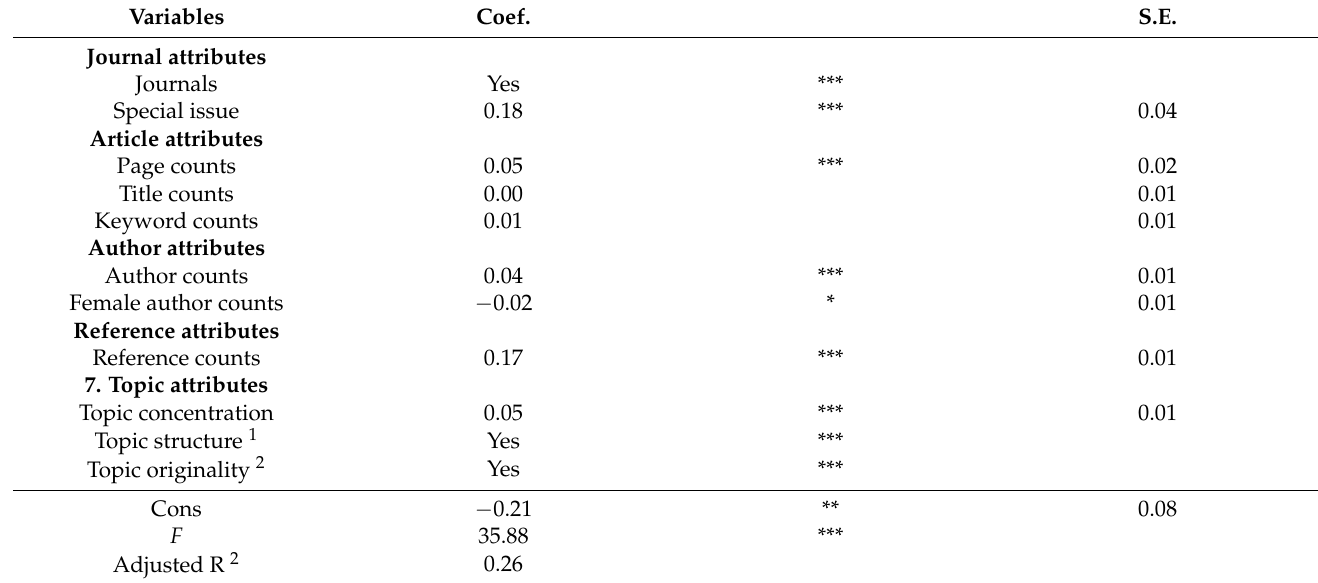
Table 4 indicates the effects of topic structure and topic originality on scientific